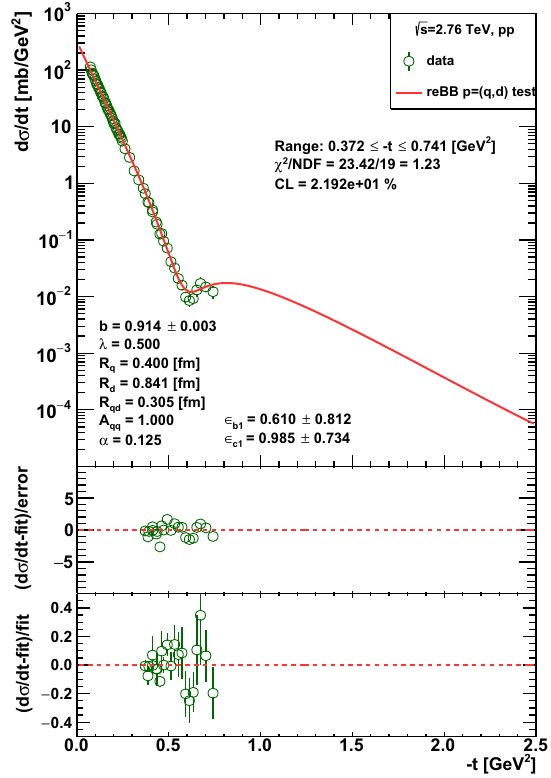
√ √ Fig. 25 Validation plot of the H ( x ) scaling at s = 2 . 76 TeV within Fig. 26 Validation plot of the H ( x ) scaling at s = 0 . 546 TeV within the framework of the ReBB model. As indicated on this plot such a the framework of the ReBB model. As indicated on this plot this con- constraint is satisfied with a CL = 21.9% (cid:20) 0.1% for the pp data, straint is satisfied with a CL ≥ 0.1% for the measured p ¯ p data, but only in the − t range of the measurement, 0 . 372 ≤ − t due to the limited in a rather limited − t range of 0 . 375 ≤ − t ≤ 0 . 56 GeV 2 , which is less validity of the ReBB model at low values of | t | . At large values of − t , than the domain of validity of the ReBB model the dominant limitation is the experimental acceptance – it is less than the limitation of the ReBB model. The good quality of the agreement betweentheTOTEMdataandthe H ( x ) scalinglimitoftheReBBmodel mined from this plot, as apparently x max ( 2 . 76 ) (cid:20) 12 . 7 of Ref. [30] is also indicated on the lower panels of this plot